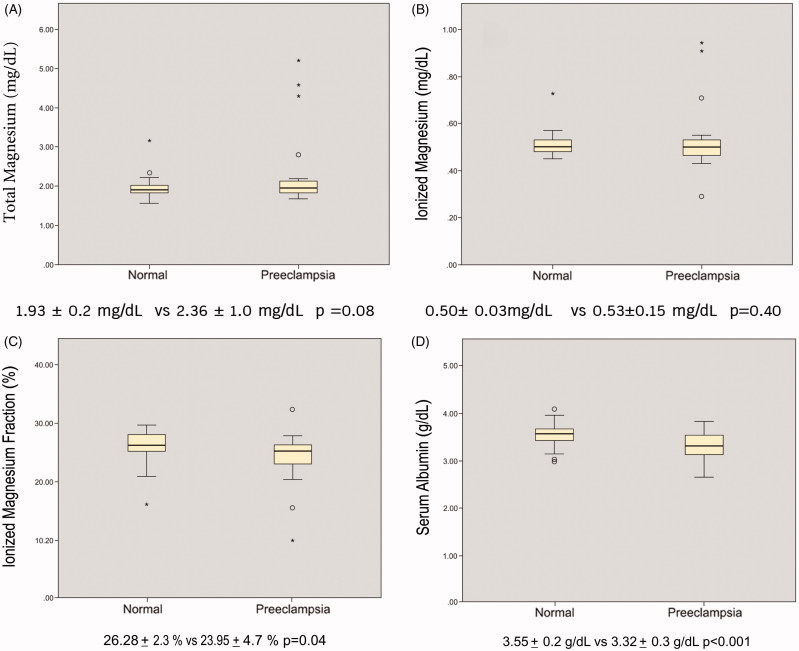
The box plots of the mean and SD of laboratory results: they demonstrated total magnesium levels (Picture A), ionized magnesium levels (Picture B), ionized magnesium fraction (%) (Picture C) and serum albumin levels (Picture D) during normal pregnancy and pregnancy with preeclampsia. Only ionized magnesium fraction and serum albumin levels showed the significant different between normal pregnancy and preeclampsia.